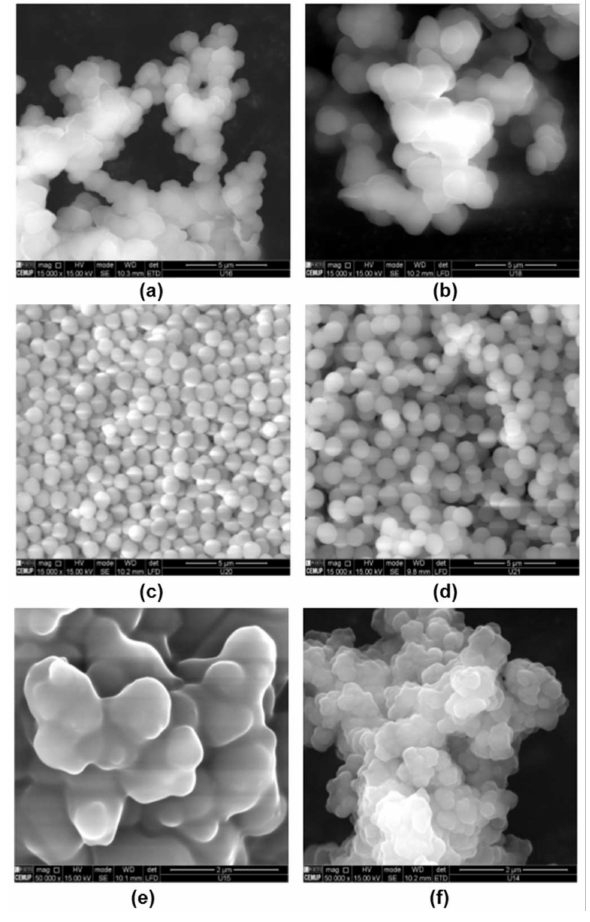
Figure 9. SEM images for different MIPs synthesized in this research: ( a ) MIP1 (prec. MAA/ACN/MeOH); ( b ) MIP3 (prec. AAm/ACN/MeOH); ( c ) MIP5 (prec.